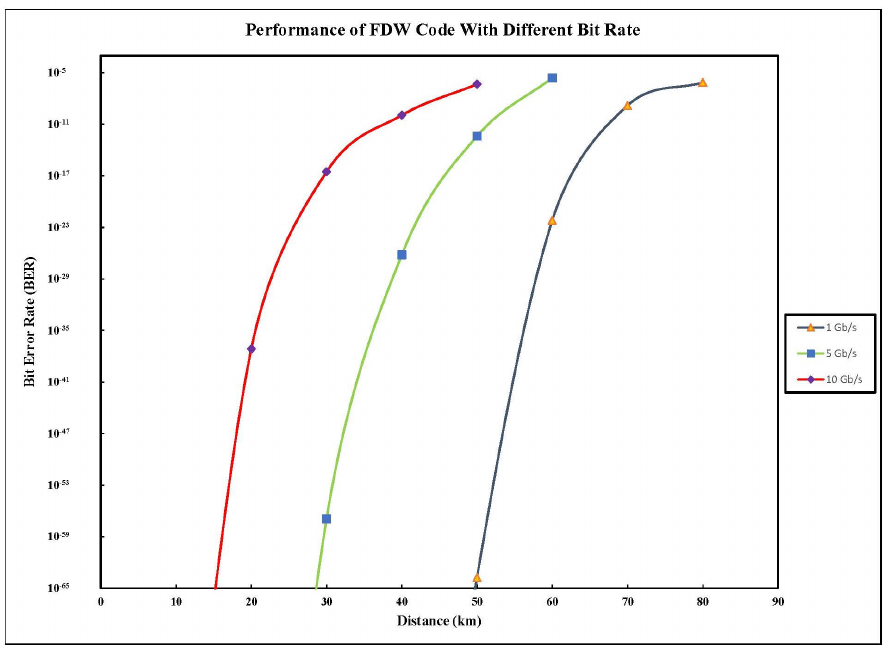
Figure 5. Performance of FDW code with different bit